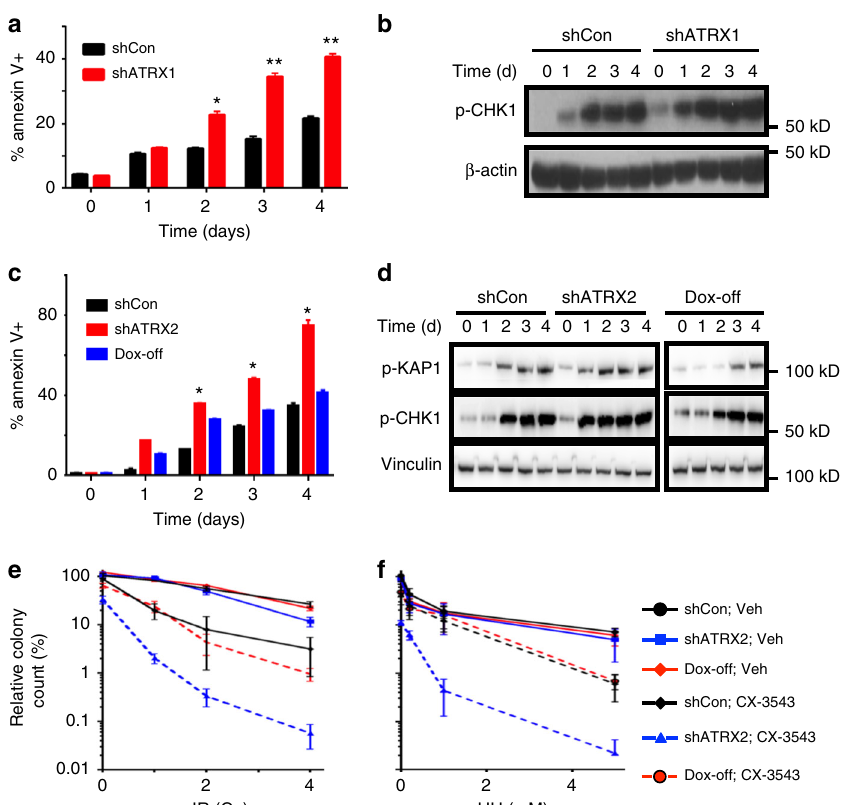
Fig. 6 G4 stabilization selectively promotes apoptosis and synergizes with DNA-damaging therapies. a , b Time course study in shCon and shATRX1 NHAs (three replicates each) treated with 100 nM CX-3543 showing parallel kinetics of apoptosis (Annexin V positivity) ( a ) and p-CHK1/p-KAP1 levels by western blot ( b ). c , d Analogous time course study in inducible shATRX2 cells (three replicates each) documenting p-CHK1 an p-KAP1 levels ( d ) by western blot and Annexin V positivity ( c ) over time. e , f Soft agar colony counts for NHAs (3 replicates each) treated with either vehicle control (Veh) or 50 nM CX-3543 and either increasing doses of IR ( e ) or HU ( f ). Colony counts measured at 21 days scaled to that of shCon, Veh NHAs. Where applicable, error bars re fl ect SEM; P values determined by two-way ANOVA (* P < 0.05, ** P <